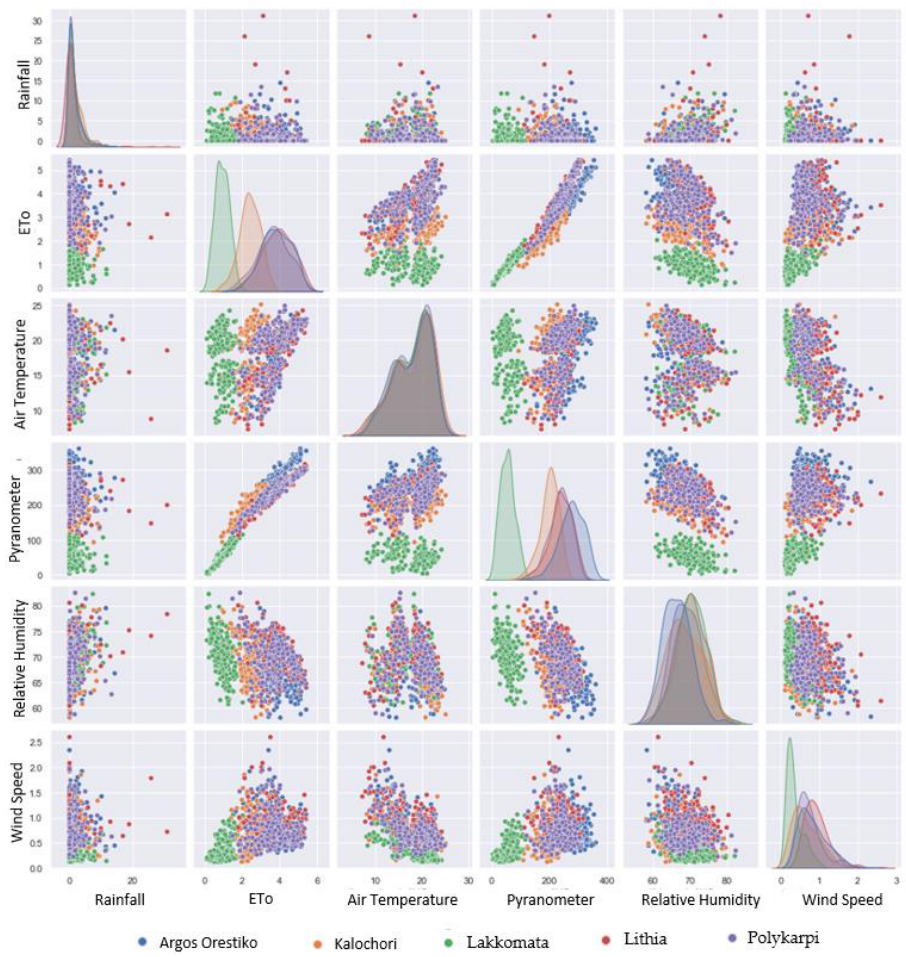
Figure 3. Pairwise plots of wind speed (km/h), relative humidity (%), pyranometer (W/m 2 ), air temperature (°C), ETo (mm) and rainfall (mm) from Kastoria.